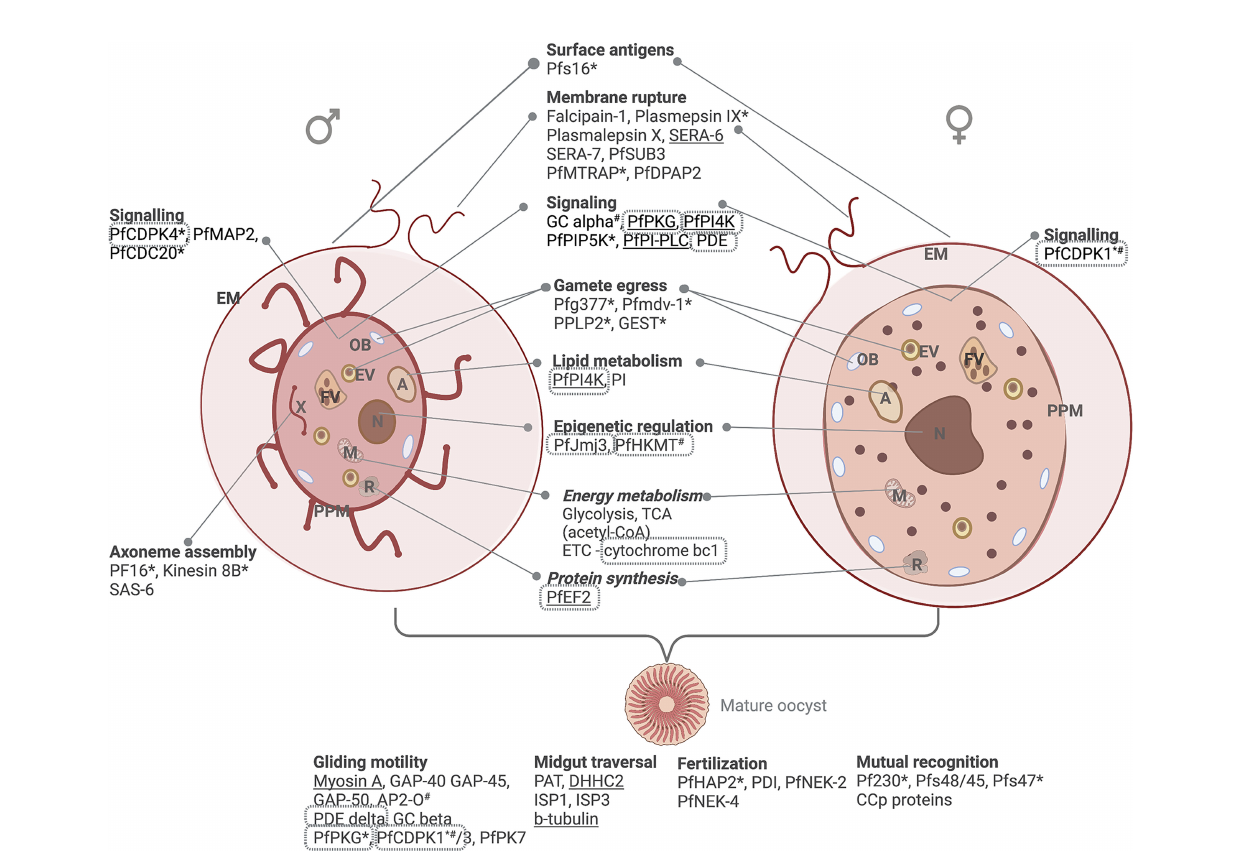
FIGURE 4 | Male and female gametes and their differentiative biological processes. Gametogenesis involves intracellular signaling, DNA synthesis, lipid metabolism and energy metabolism reminiscent of the asexual stages (glycolysis and TCA cycle). Protein essentiality (www.phenoPlasm.org) is indicated by a * (gametocytes) or # (asexual stages) or underlined where the gene is refractory to deletion. Proteins that are validated as potential target through chemical inhibition are indicated in grey borders. EM, erythrocyte membrane; ER, Endoplasmic reticulum; A, acidocalcisome; EV, egress vesicle; OB, osmiophillic body; PPM, parasite plasma membrane; FV, food vacuole; N, nucleus; M, mitochondrion and R, ribosome. Protein names are explained in